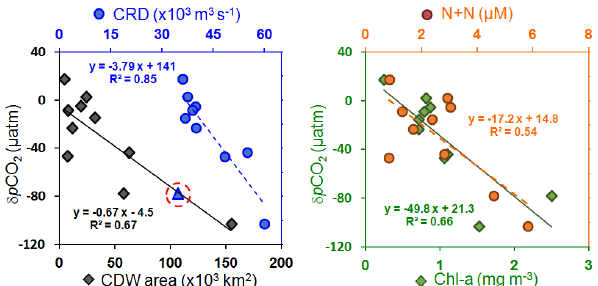
Figure 4. Relationships between δp CO 2 and (a) the CDW plume area or the CRD; and (b) N+N and Chl a in summer from July 1998 to July 2011 in the ECS shelf. “ − “ indicates uptake of CO 2 by shelf water from the atmosphere. The best-fit lines by a linear regression analysis ( n = 10, all p values < 0.001) are shown in the plume area and Chl a (solid line) and in CRD and N + N (dashed line), respectively. The CRD denotes average Changjiang River dis- charge data collected at Datong station during the LORECS cruise period. The blue circled triangle denotes the data point from the OR1-686 cruise, which was excluded from the regression